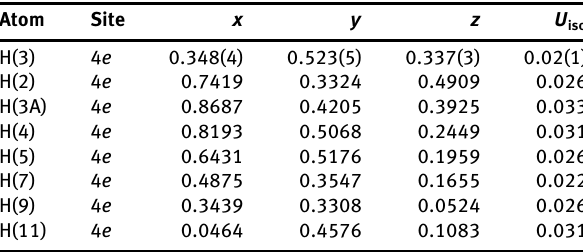
Table 2: Fractional atomic coordinates and isotropic or equivalent isotropic displacement parameters (Å 2